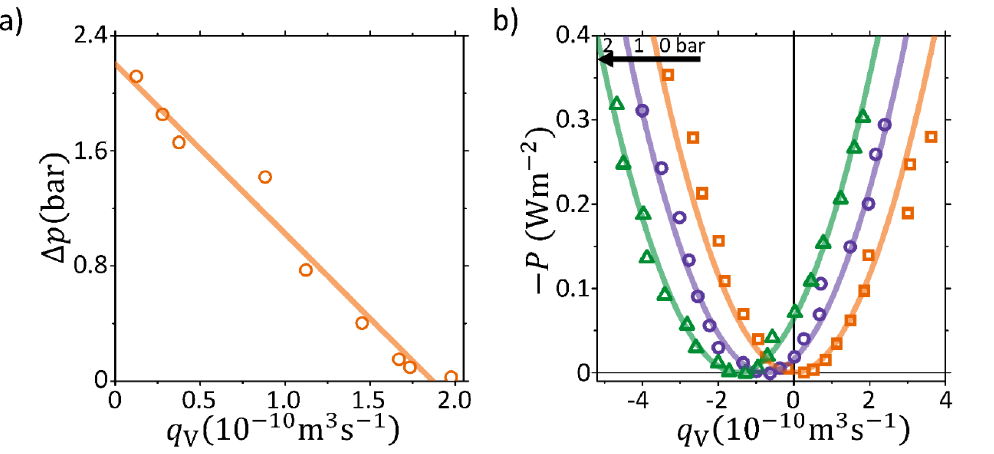
Figure 3. ( a ) Pump curve at I = − 42.3 mA, pressure difference ( ∆ p ) versus volume flow ( q V ) through the membrane, for the EKEC microfluidic pump. ( b ) Electrical power ( P ) versus q V for 0, 1, and 2 bar pressure difference. Lines are fits to the model of Equation (3), yielding κ H = 1.55 × 10 − 17 m 2 Pa − 1 s − 1 and β = 0.21 for A = 25 cm 2 and membrane thickness (in fully hydrated conditions) ∆ x = 60 µ m. Each data point is calculated by an average of 30 raw data points in a 60 s time